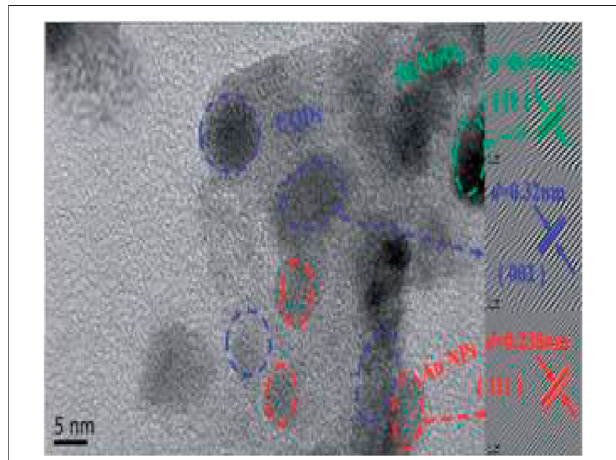
FIGURE 11 | HTEM image of CQDs/Au/BMO nanocomposite. (Reproduced from Zhao et al., 2021, Royal Society of